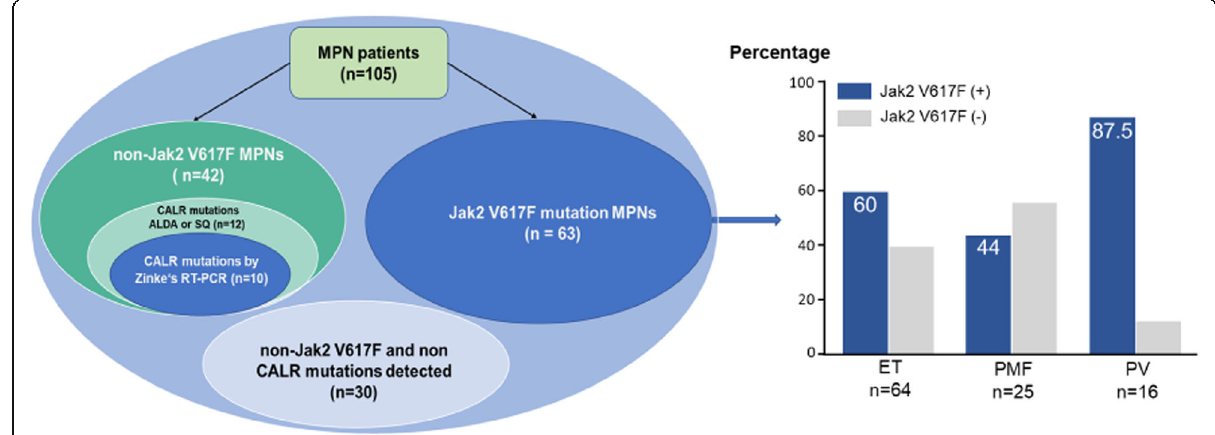
Fig. 5 Evaluation of PCR-ALDA compared to Sanger sequencing and real-time PCR. Venn diagram and bar graph illustrating the distribution of Jak2 V617F and CALR mutations among 105 MPN patients. Screening for Jak2 V617F was performed by ARMS-PCR and detection of CALR mutants by PCR-ALDA, real-time PCR (rt-PCR) and by direct Sanger sequencing